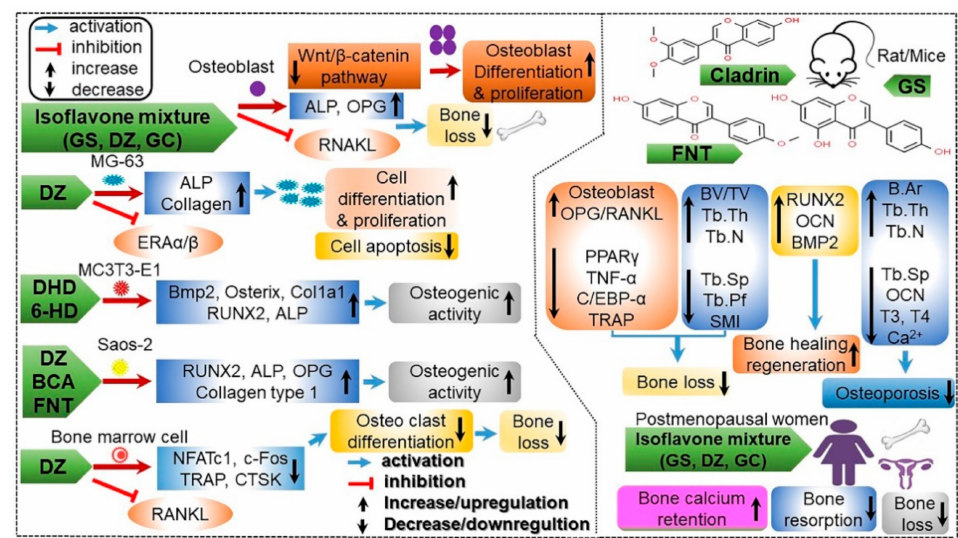
Figure 10. Antiosteoporotic effects of daidzein (DZ), genistein (GS), glycetin (GC), and their metabo- lites [6-hydroxydaidzein (6-HD), formononetin (FNT), dihydrodaidzein (DHD), biochanin A (BCA), and cladrin] through modulation of gene expression at transcriptional and translational levels in different bone cell types. Cell differentiation and proliferation, osteogenic activity, and bone health (such as bone density) is enhanced, whereas apoptosis, bone loss, and bone resorption are attenuated in experimental settings (involving MG-63, MC3T3-E1, Saos-2, and bone marrow cells and in vitro experiments in rats/mice). In osteoblast cells, GS, DZ and GC upregulate the expression of genes associated with alkaline phosphatase (ALP) and osteoprotegerin (OPG), and downregulate Wnt/ β - catenin pathway, whereas they inhibit receptor of activator of nuclear factor kappa B ligand (RANKL). DZ induces increased ALP and collagen synthesis, and inhibits estrogen receptor A alpha/beta (ERA α / β ) in MG-63 cells. DZ also decreases the expression of genes associated with nuclear factor of activated T-cells cytoplasmic 1 (NFATc1), cellular oncogene fos (c-Fos), tartrate-resistant acid phosphatase (TRAP) and cathepsin K (CTSK), as well as inhibits RANKL in bone marrow cells. DHD and 6-HD upregulates the expression of genes associated with the bone morphogenetic protein 2 (BMP2), transcription factor Sp7 (Osterix), alpha-1 type I collagen (COL1a1), runt-related transcription factor 2 (RUNX2), and ALP in MC3T3-E1 cells. DZ, BCA, and FNT increase the expression of genes associated with RUNX2, ALP, OPG, and COL1 in Saos-2 cells. As shown in the right panel, cladrin, GS, and FNT improve bone health by regulating a wide range of genes in rat and mice. In addition, mixed intake of GS, DZ, and GC increases bone calcium retention and decreases bone resorption and bone loss in postmenopausal women [78]. ↑ , enhancing; ↓ , lowering; → , activation; ┤ , inhibition. Figure adapted from Kim et al.